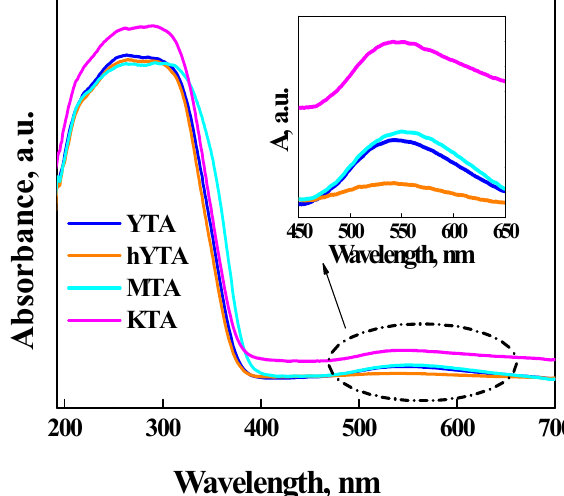
Figure 6. UV-Vis spectra of Ti-Au photocatalysts.